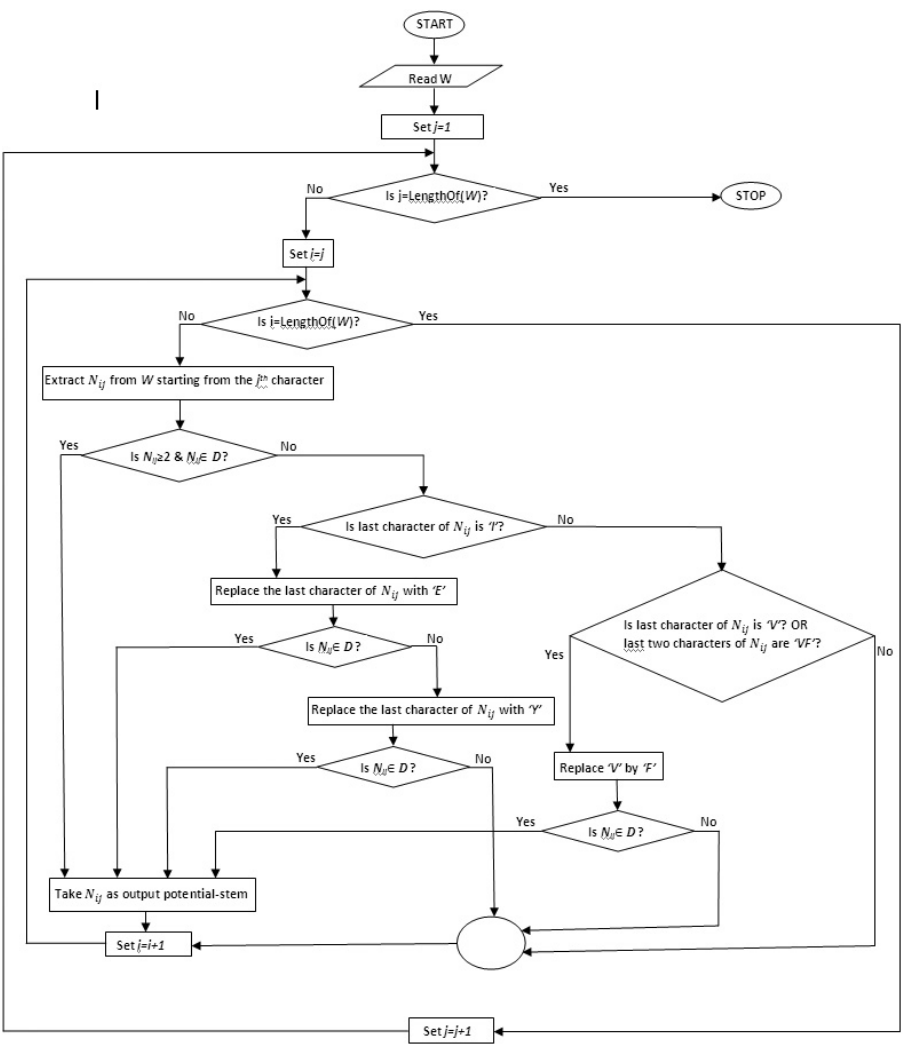
Fig. B.1. Flowchart for the present